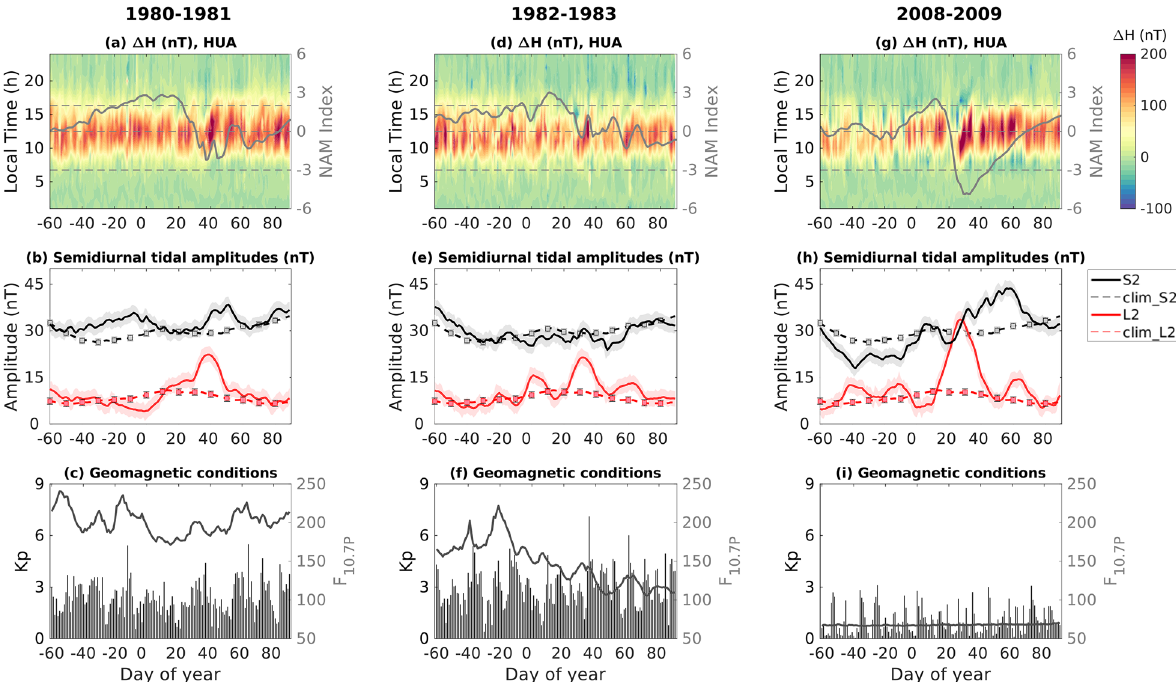
Fig. 1 Panels a , d and g show the local time variation of ∆H from 1st November to 31st March for the winters of years 1980–1981, 1982–1983 and 2008–2009, respectively. The solid gray lines in the top panels represent the NAM values, while dashed gray lines correspond to the NAM value of 2 and -3 associated with the reference values for strong and weak SPV, respectively. In panels b , e and h , the amplitudes of semidiurnal solar (solid black line) tide and its climatology (dashed black line) are shown for the same years as mentioned above. In a similar way, the amplitudes of semidiurnal lunar (solid red line) tide and its climatology (dashed red line) are shown in these figures. The gray and red shadings in these panels indicate the 95% confidence intervals of semidiurnal solar and lunar tides, respectively. The error bars indicate the 95% confidence intervals of the climatological tidal amplitudes. Panels c , f and i show the averaged daily Kp values in black bars and daily F 10.7P levels in solid gray